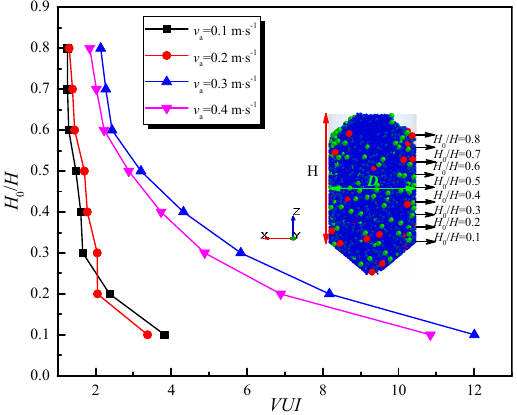
Figure 29. The variation in VUI for different sinter layers with different discharge velocities.